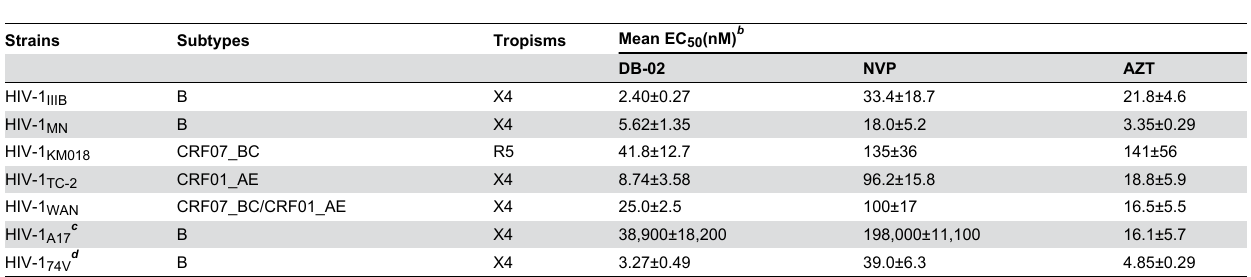
Table 1. Anti-HIV-1 activity of DB-02 against laboratory adaptive strains, clinical isolated strains, and RT resistant strains a .